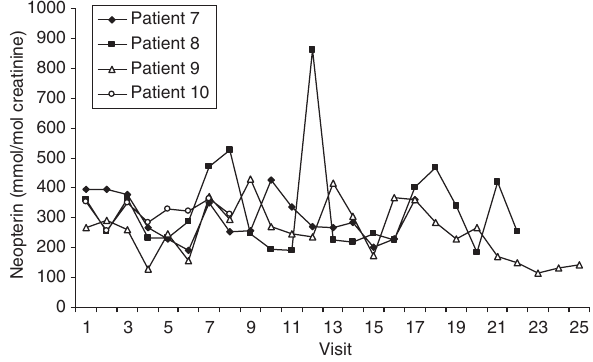
Figure 3 Urinary neopterin concentrations during the course of